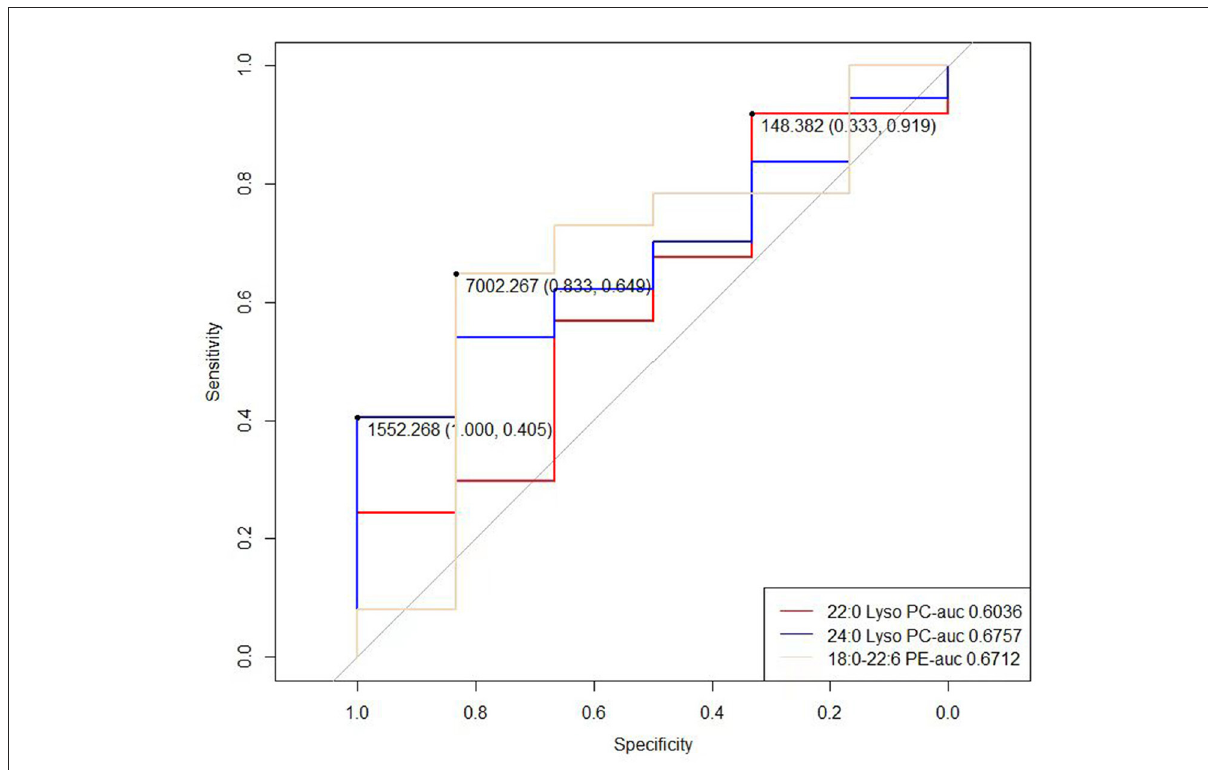
FIGURE2 ROC curve of the 22:0 Lyso PC, 24:0 Lyso PC, 17:1 Lyso PI and 18:0–22:6 PE in RN group (rotator cuff tear with normal routine serum lipid test).